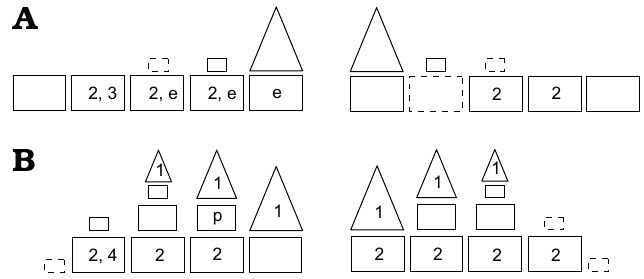
Fig. 1. Schematic drawing of the left and right manual ( A ) and pedal ( B ) phalanges of the camarasaurid sauropod SMA 0002, marking the el- ements affected by pathologies described herein. Rectangles are normal phalanges, triangles are unguals. Dashed lines indicate lacking elements. Numbers correspond to the overgrowth types as defined in the text; e, pos- sible eburnation; p, deep